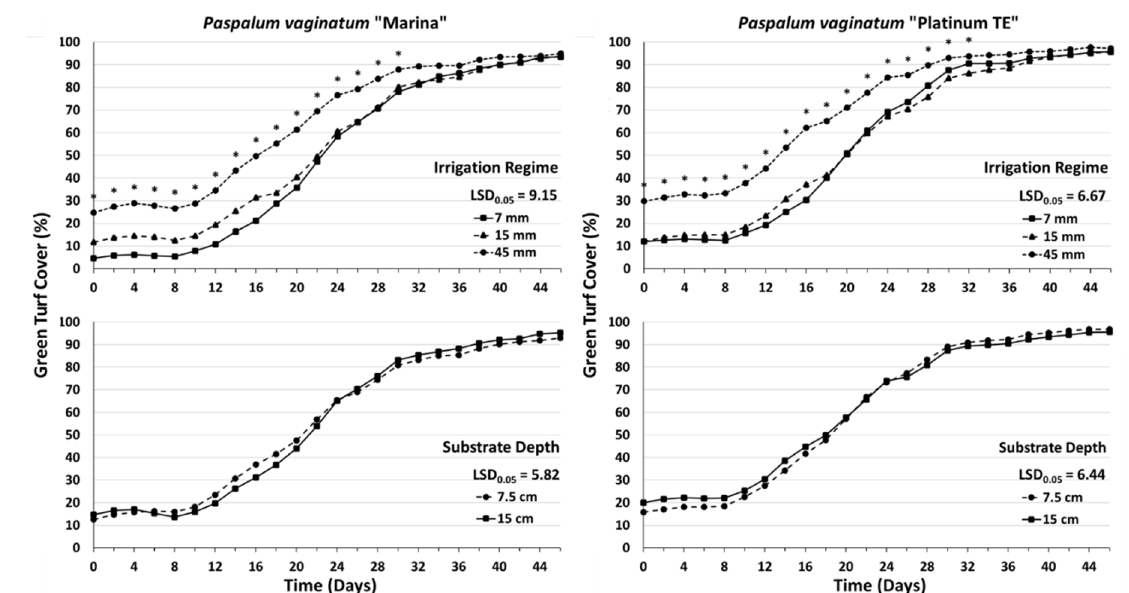
Figure 7. Green turf cover (%) of the two Paspalum vaginatum varieties “Marina” and “Platinum TE” during the recovery period using 7 mm irrigation with potable water every other day (15 September–31 October 2016), as affected by seawater irrigation regimes during the salinity stress period (7 mm, 15 mm, or 45 mm) and green roof substrate depth (7.5 cm or 15 cm). Values are the mean of 4 replications. Asterisks (*) indicate significant differences in-between treatment means on a single sampling date, according to Fisher’s least significant difference (LSD) at p < 0.05 following the repeated measures model.